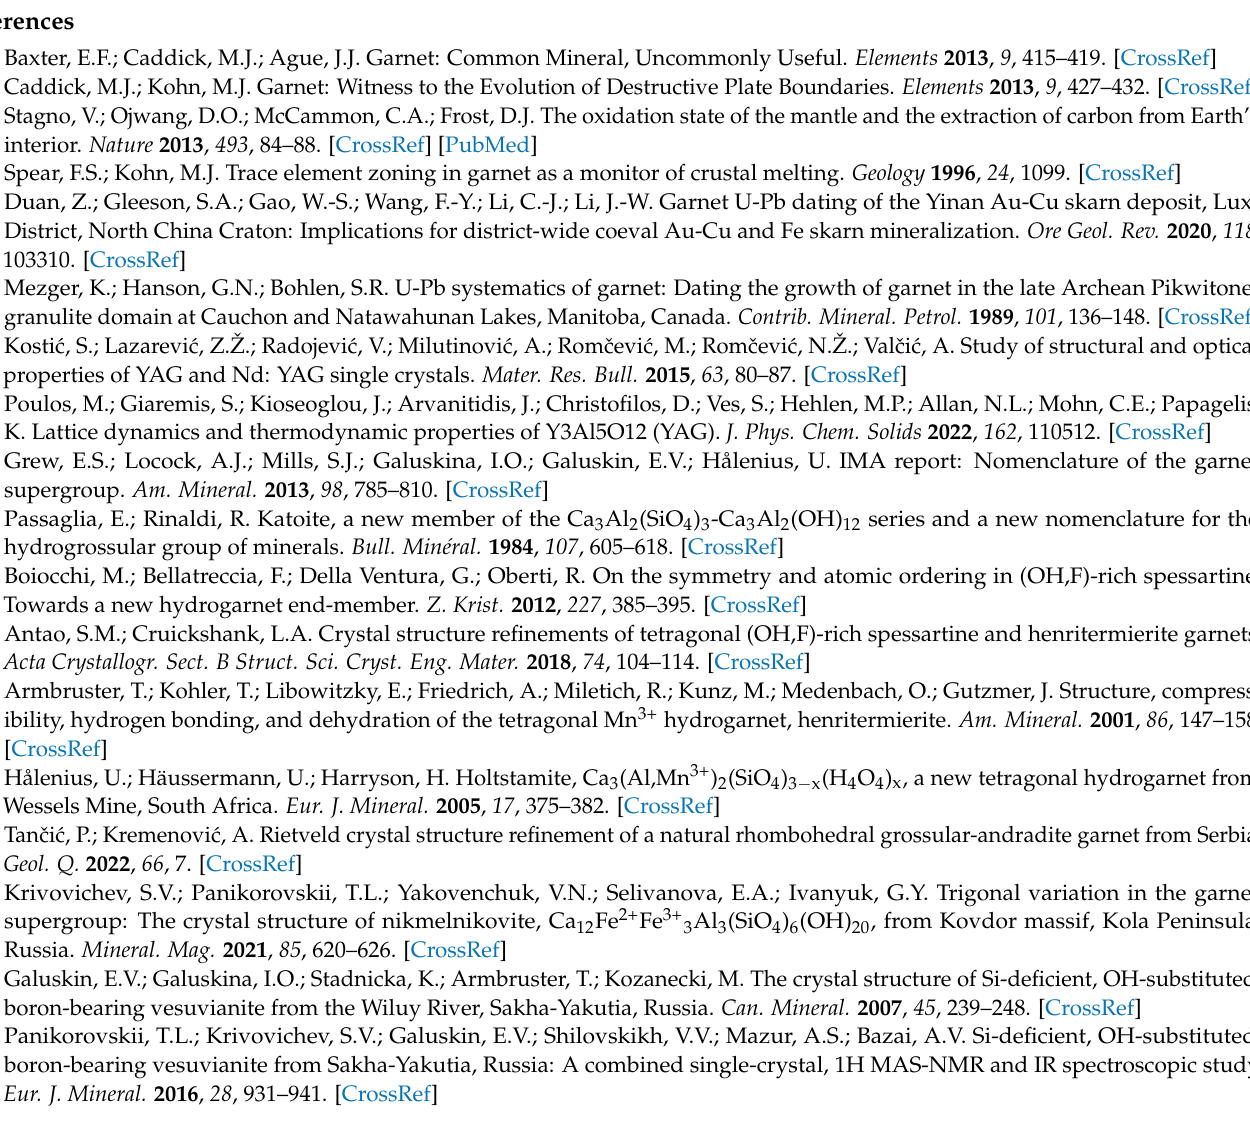
Russia. Table S2: Selected interatomic distances (Å) for (H 4 O 4 ) 4 − -substituted grossular from